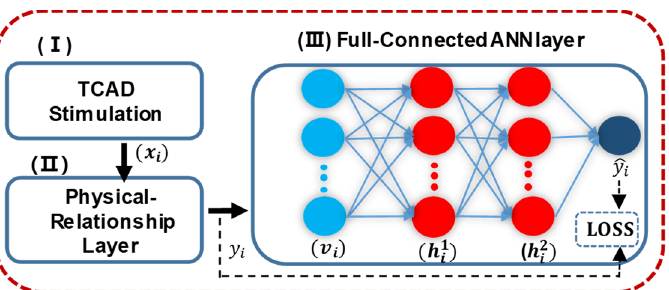
Figure 1. Schematic of the PRNN Framework. Stimulation data from TCAD is firstly transformed at the physical-relationship layer to contain more fundamental relations of physics. Then, the pretreated data is trained by fully-connected artificial neural networks.